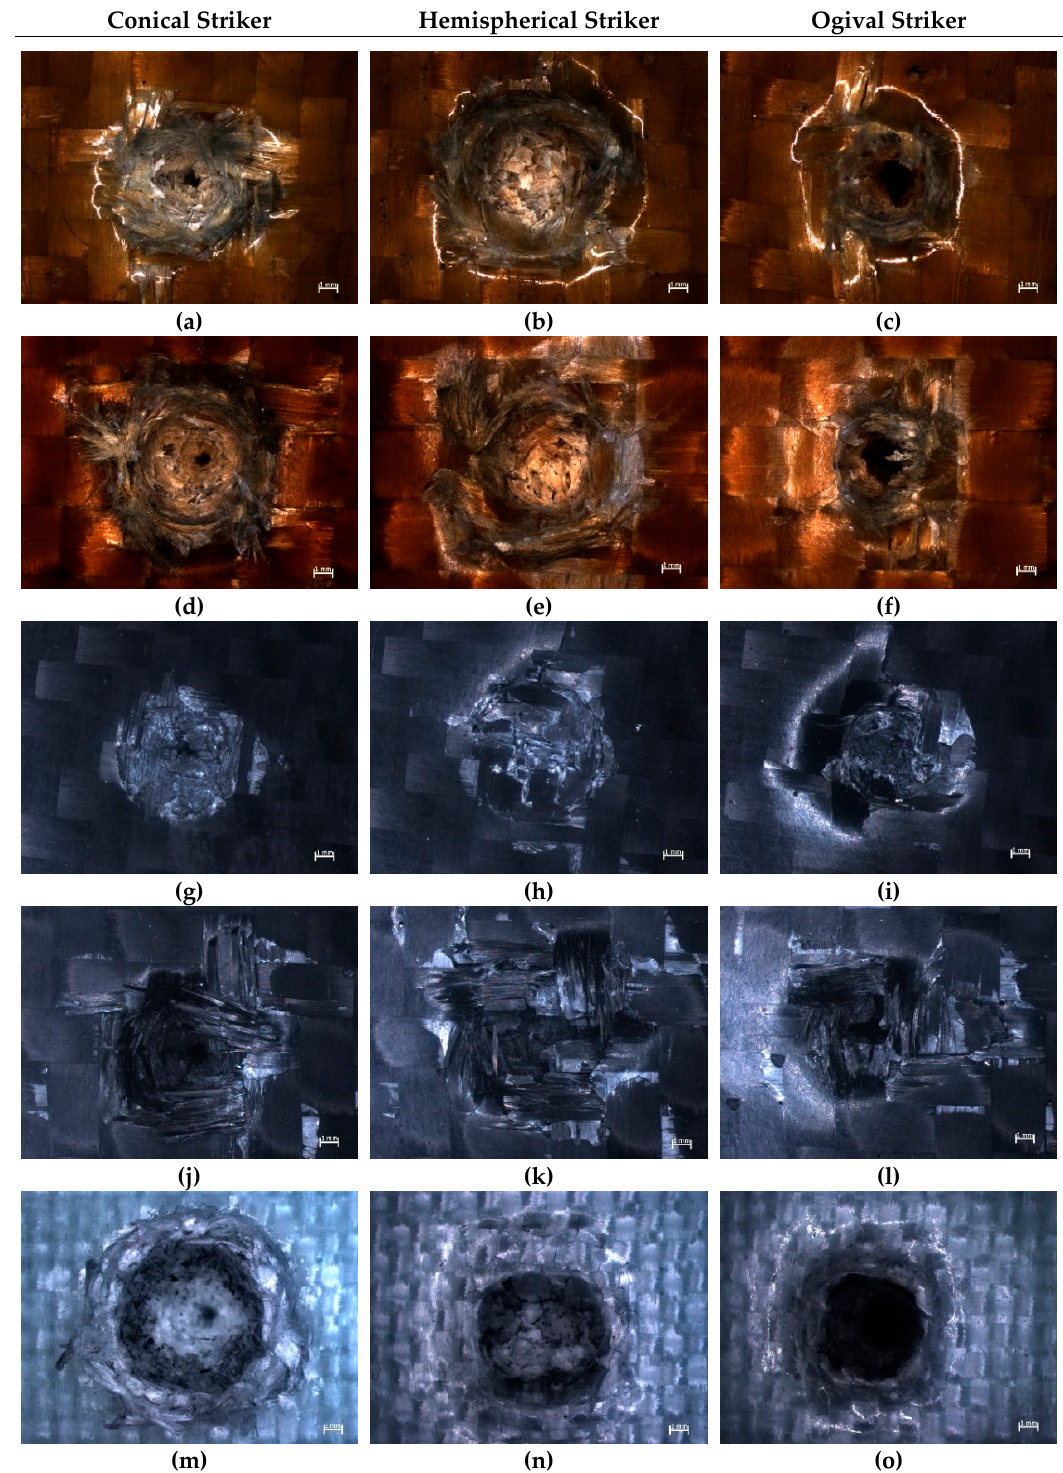
Figure 5. Microscopic images of damage caused by the strikers with various geometry in the epoxy composites with reinforcement made from the following fibers: ( a – c ) Twaron 2200, ( d – f ) Kevlar 49,